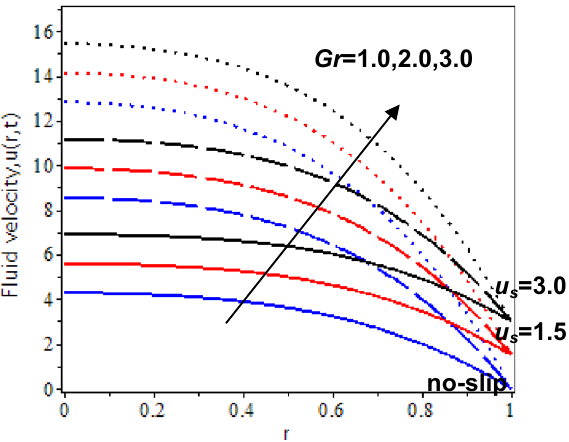
Figure 8. Nanofluid velocity with various Grashof number and slip velocity at t = 2.5